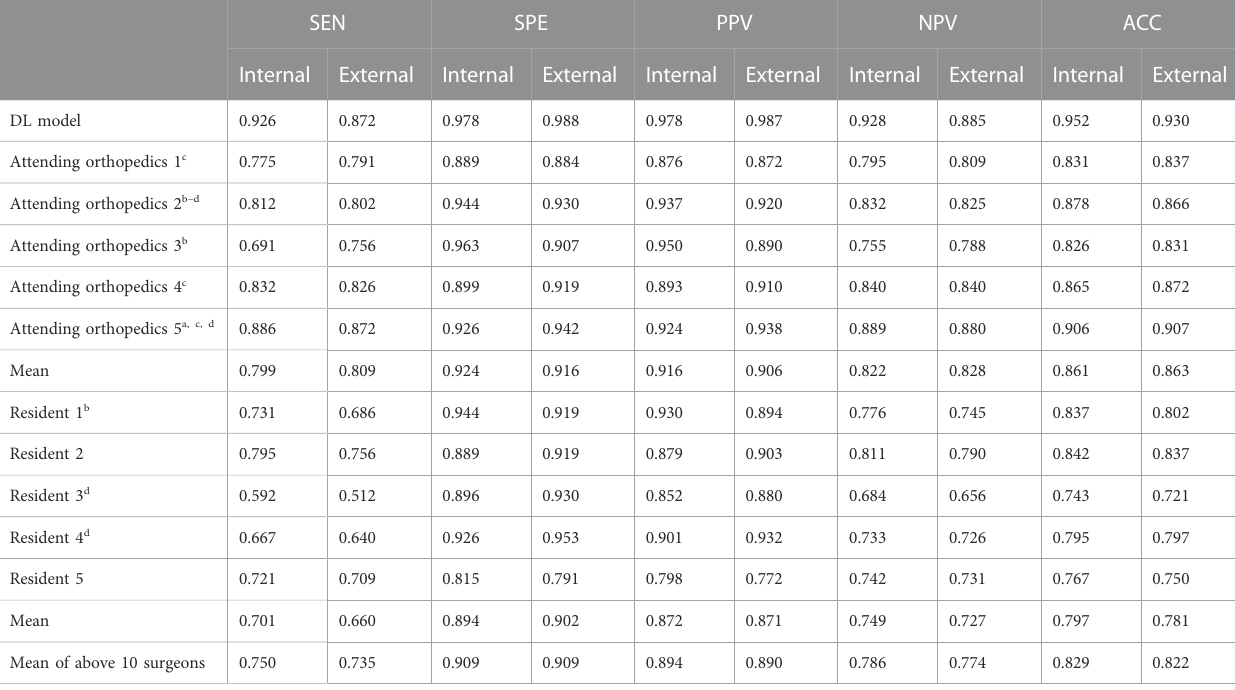
TABLE 2 Performance comparison between the DL model and clinicians in detecting acetabular